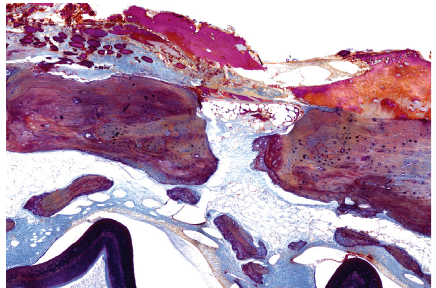
Figure 1: Histotopogram of the rabbit’s mandible cross section, 2 weeks after the formation of a bone defect and placement of calcium hydroxide suspension.